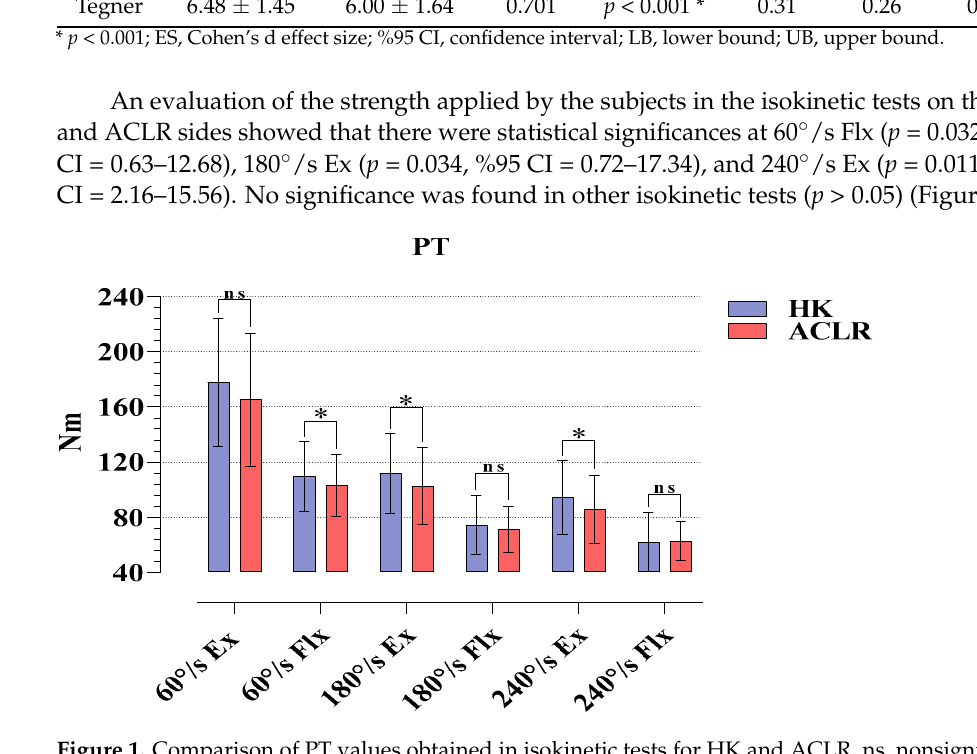
Figure 2. Comparison of H/Q ratios obtained in isokinetic tests for HK and ACLR. ns, nonsignifi- cant; HK, healthy knee; ACLR, anterior cruciate ligament reconstruction knee; H/Q, ham- string/quadriceps. In Figure 3, the JAPT parameters revealed by the subjects at different angular veloc- ities in the isokinetic tests on the HK and ACLR sides are compared. The results show that there was no statistical significance in the Ex and Flx phases at any angular velocity ( p > 0.05).